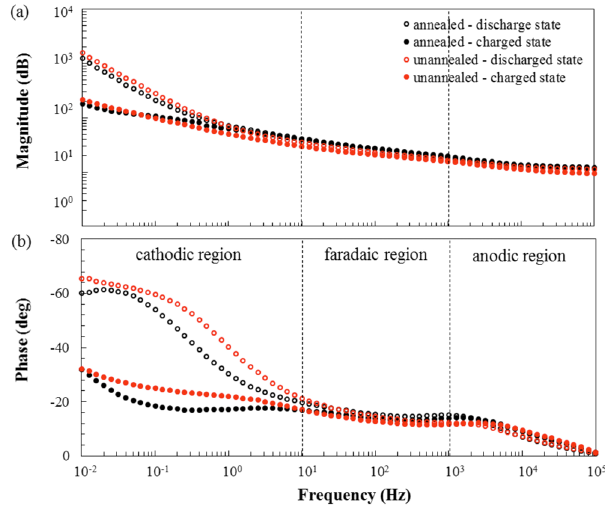
Figure 8. Bode magnitude and phase plots within the frequency range (0.01 to 10 5 )